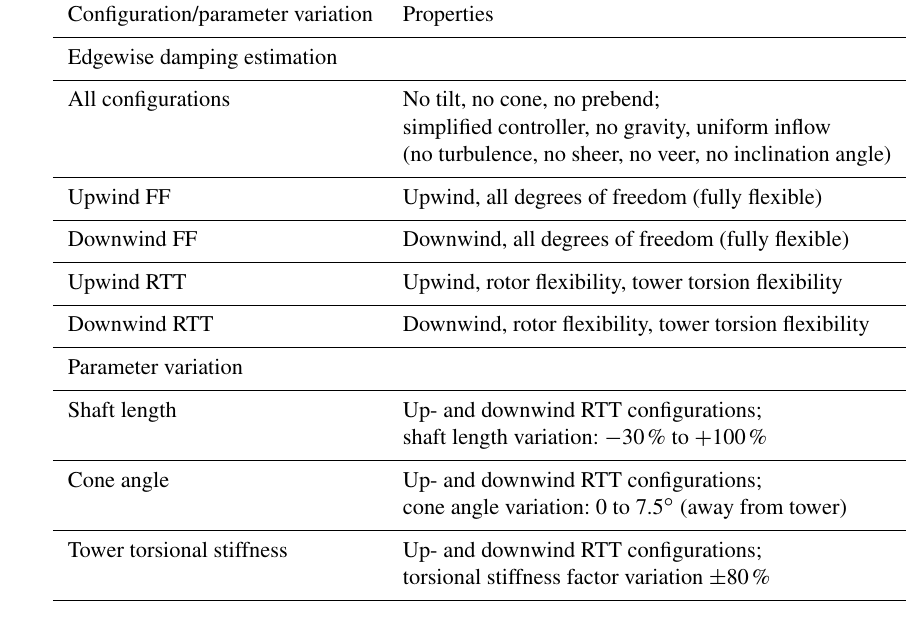
Table 1. Configurations and parameter variations.